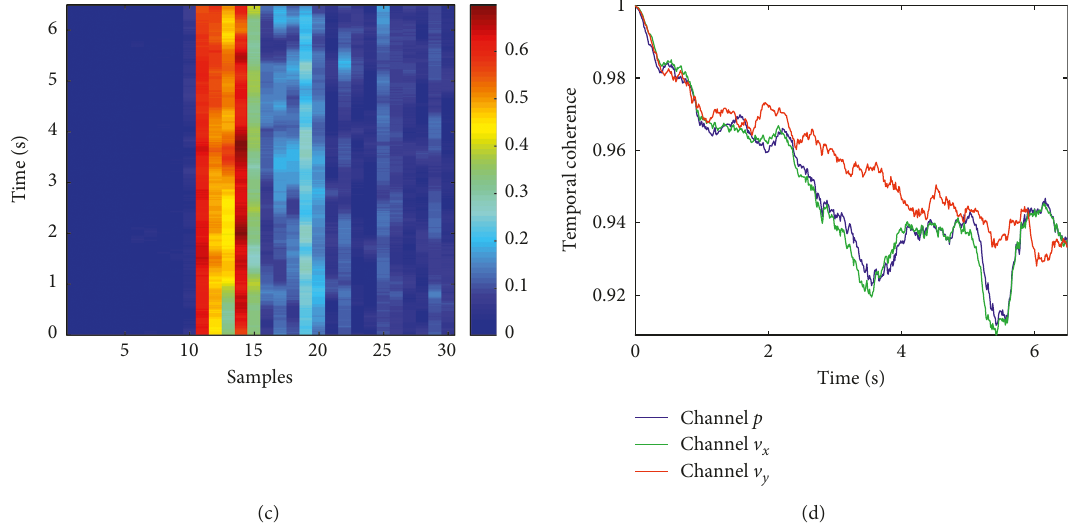
v x channel; (c) the CIR for the y channel;